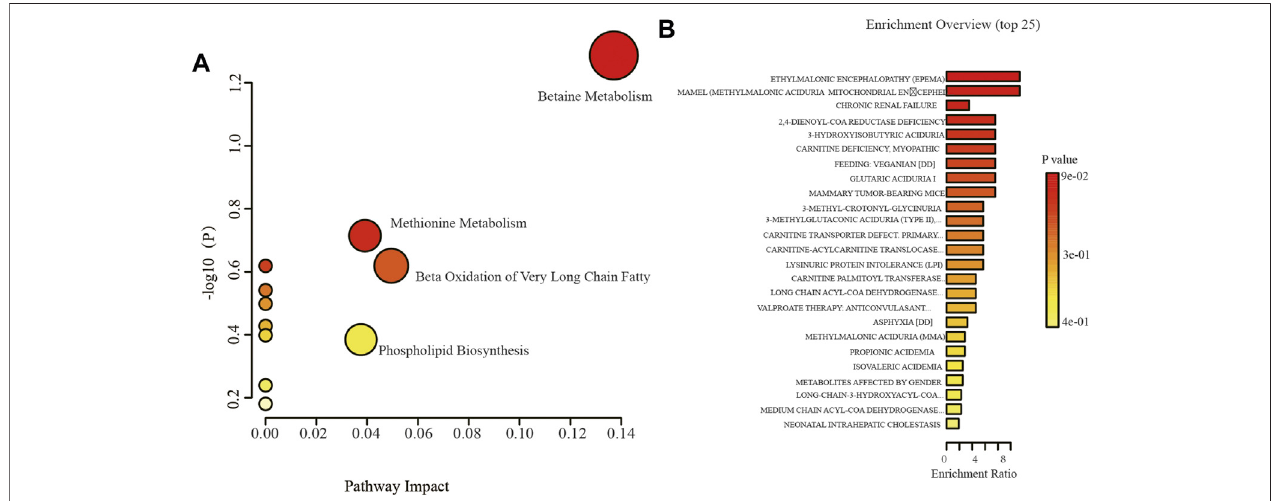
FIGURE 7 | The enrichment analysis of potential biomarkers. (A) : KEGG pathway enrichment analysis of potential biomarkers, (B) : Disease-related pathway enrichment analysis of potential biomarkers.